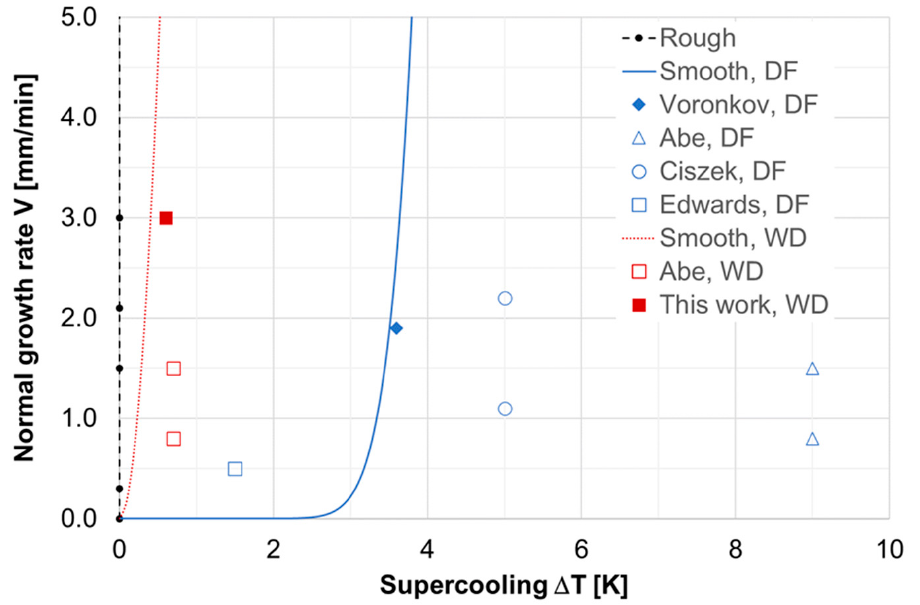
Figure 1. Growth rate V as a function of the supercooling ∆ T for a rough interface (Equation (2), black), atomically smooth, dislocation-free (111) facet (Equation (3), blue), and a (111) facet with dislocations (Equation (4), red) for silicon together with some experimental data compiled in [27]. The supercooling ∆ T determined in this work (see Section 4) for a facetted interface with dislocation is shown as a red square.